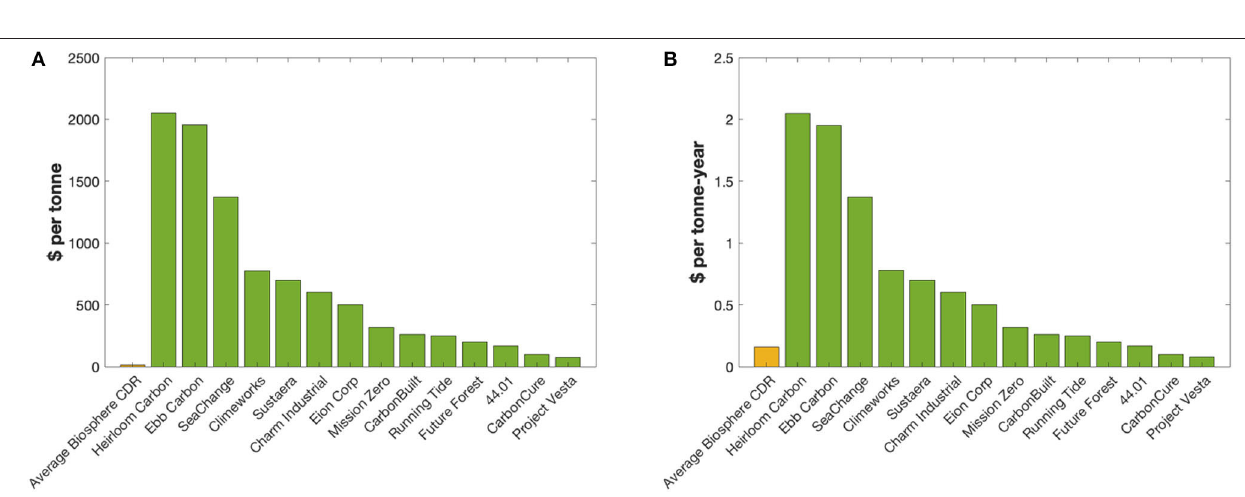
FIGURE 2 | (A) (left): The cost-per-tonne of each carbon credit in Stripe’s CDR portfolio. (B) (right): The cost-per-tonne-year of each carbon credit in Stripe’s CDR portfolio.